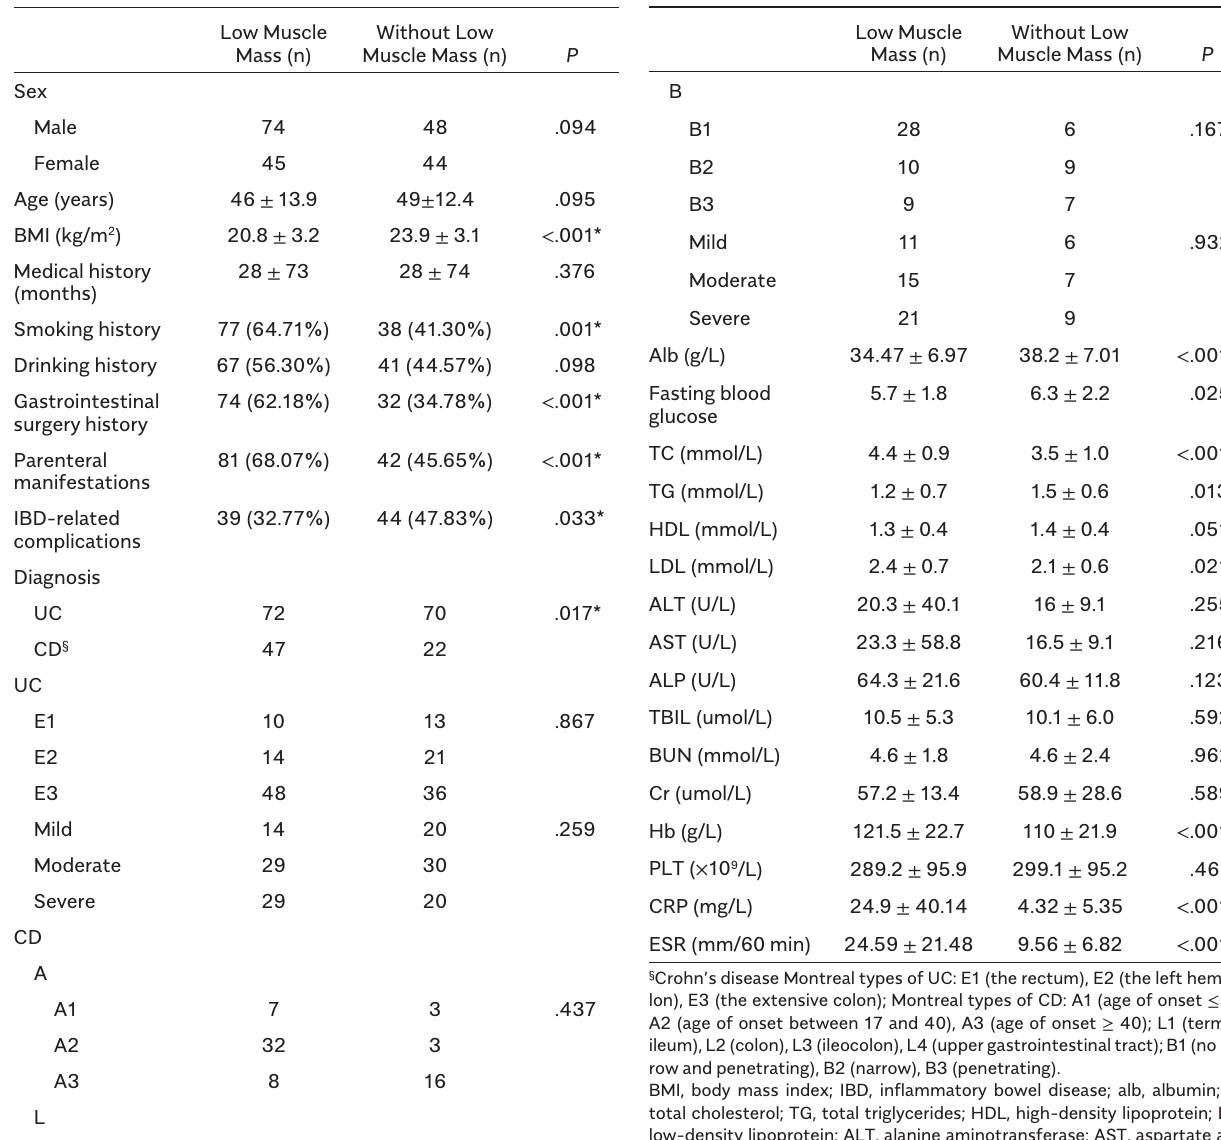
Table 1. Demographic Data in IBD Patients with Low Muscle Mass and Without Low Muscle